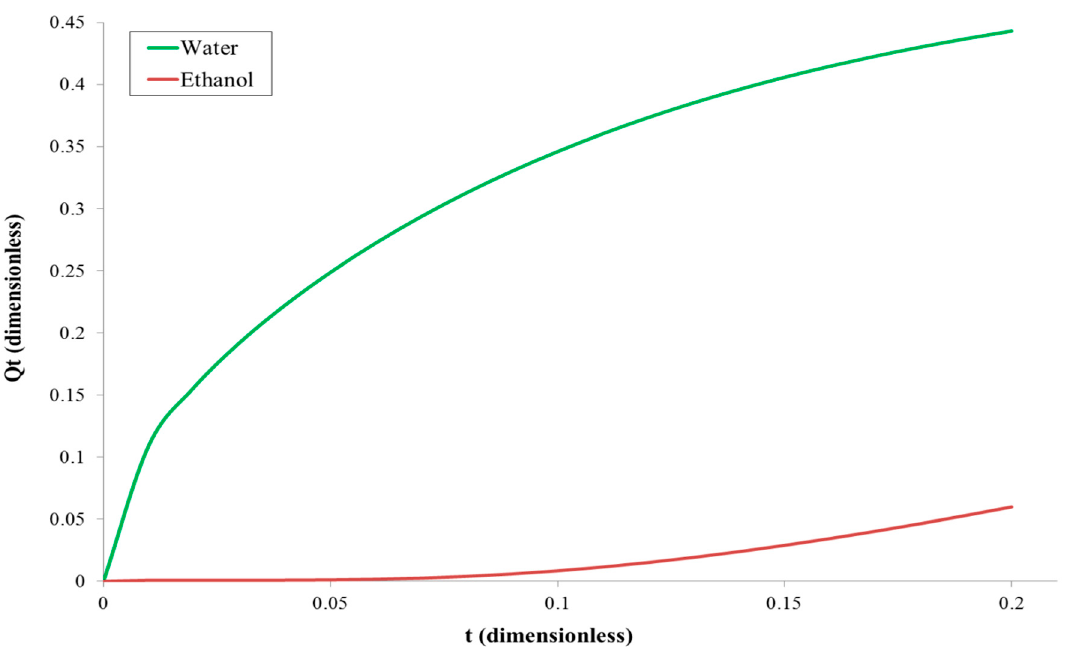
Figure 4. The relation between the total amount of diffusing water and ethanol molecules versus time in the case when the membrane is filled with water, i.e., C 0 ≠ C 1.